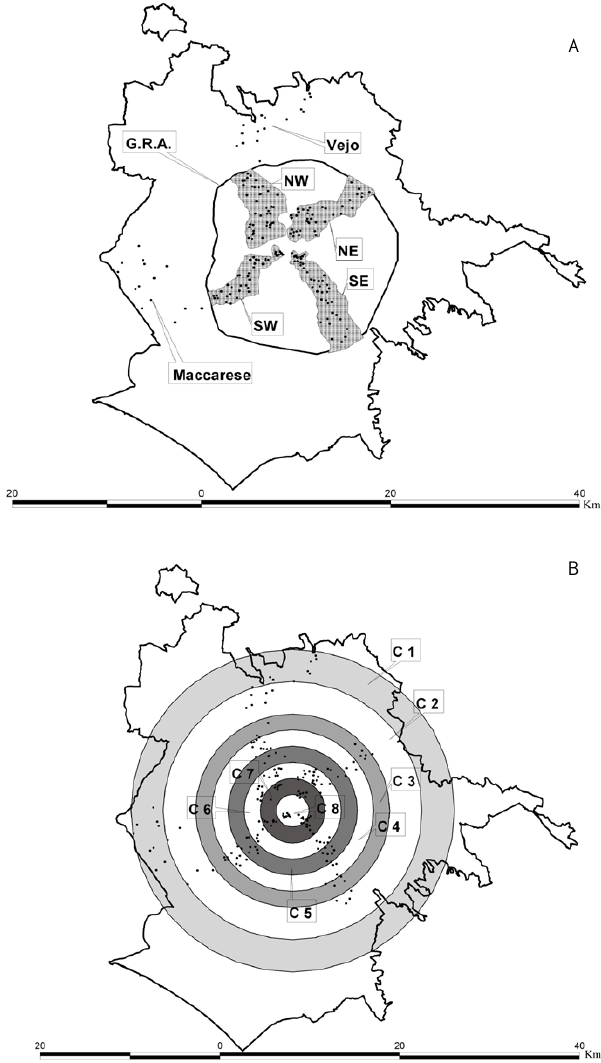
Figure 1. GIS-built maps of the study area showing (A) Municipal- ity of Rome’s borders, G.R.A. ring road, point counts’ (black dots) distribution into four sectors (grey shading), and (B) eight urbaniza- tion gradient rings (UGRs; C8-C1, urban to rural